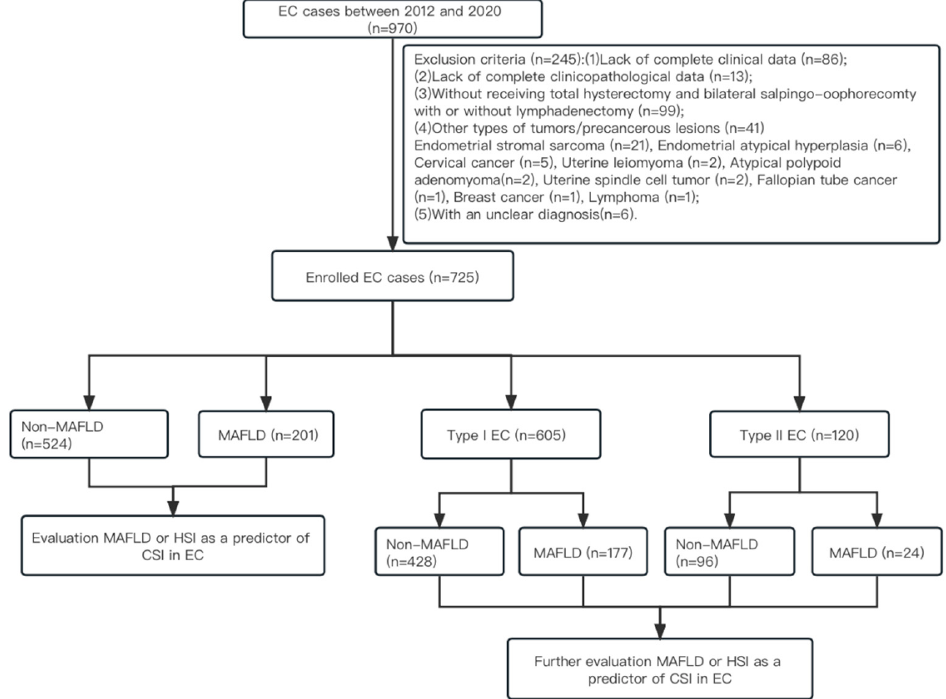
Figure 1. Flowchart of study. Abbreviations: EC: endometrial cancer; HSI: hepatic steatosis index; MAFLD: metabolic dysfunction-associated fatty liver disease; CSI: cervical stromal involvement.